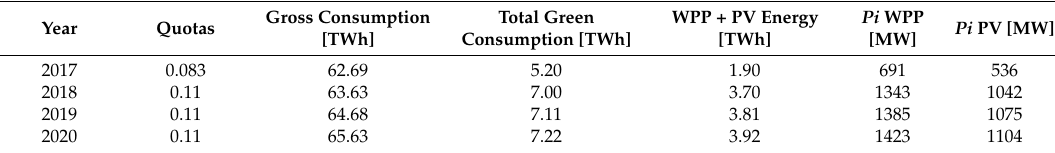
Table 3. Simulation of electricity consumption variation scenario.